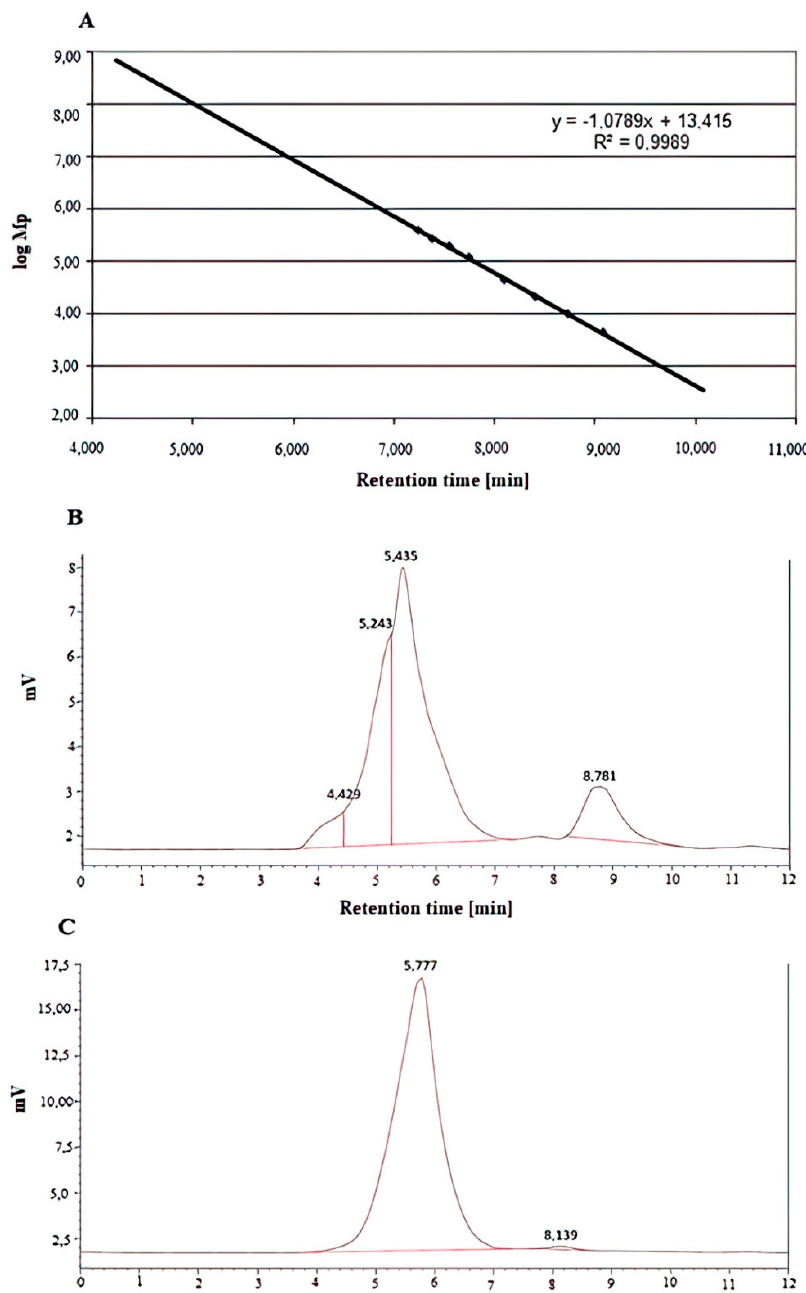
Figure 3. ( A ) Molecular weight distribution of standard β -glucans. ( B ) Chromatogram of the Le-P-0 fraction. ( C ) Chromatogram of the Le-P-Se fraction. Conditions: injection of 20 µL at a concentration of 1 mg/mL of the analyte, using a TSK gel Super Multipore PW-H 6.0 mm ID × 150 mm (TOSOH Bioscience) brand column eluted with ultrapure water (Merck, Darmstadt) as the mobile phase at a flow rate of 0.4 mL/min and conditioned at 50 °C. Mp: molecular weight corresponding to the maximum chromatographic peak.